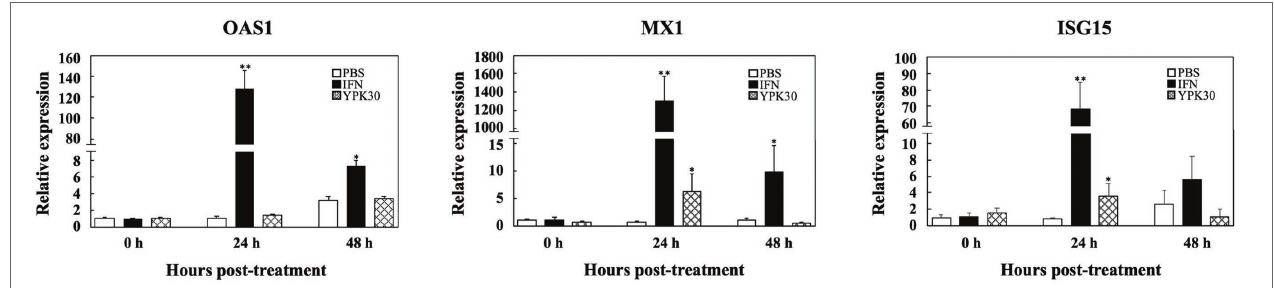
FIGURE 7 | Effect of treatment of intracellular extracts of Ln. mesenteroides YPK30 on the expression levels of Type 1 IFN-dependent genes OAS1, MX1, or ISG15 in Vero cells. Bar charts for each gene showing percentage of cell metabolic activity of three sample conditions: (1) PBS: cells treated with PBS, (2) IFN: cells treated with IFN- α 2b, and (3) YPK30: cells treated with the intracellular extracts of Ln. mesenteroides YPK30. All data are expressed as mean ± SD ( n = 3). Bars marked with a star or double stars mean that they are significantly different from the control (cells treated with PBS) at the 5 or 1% confidence level, respectively.